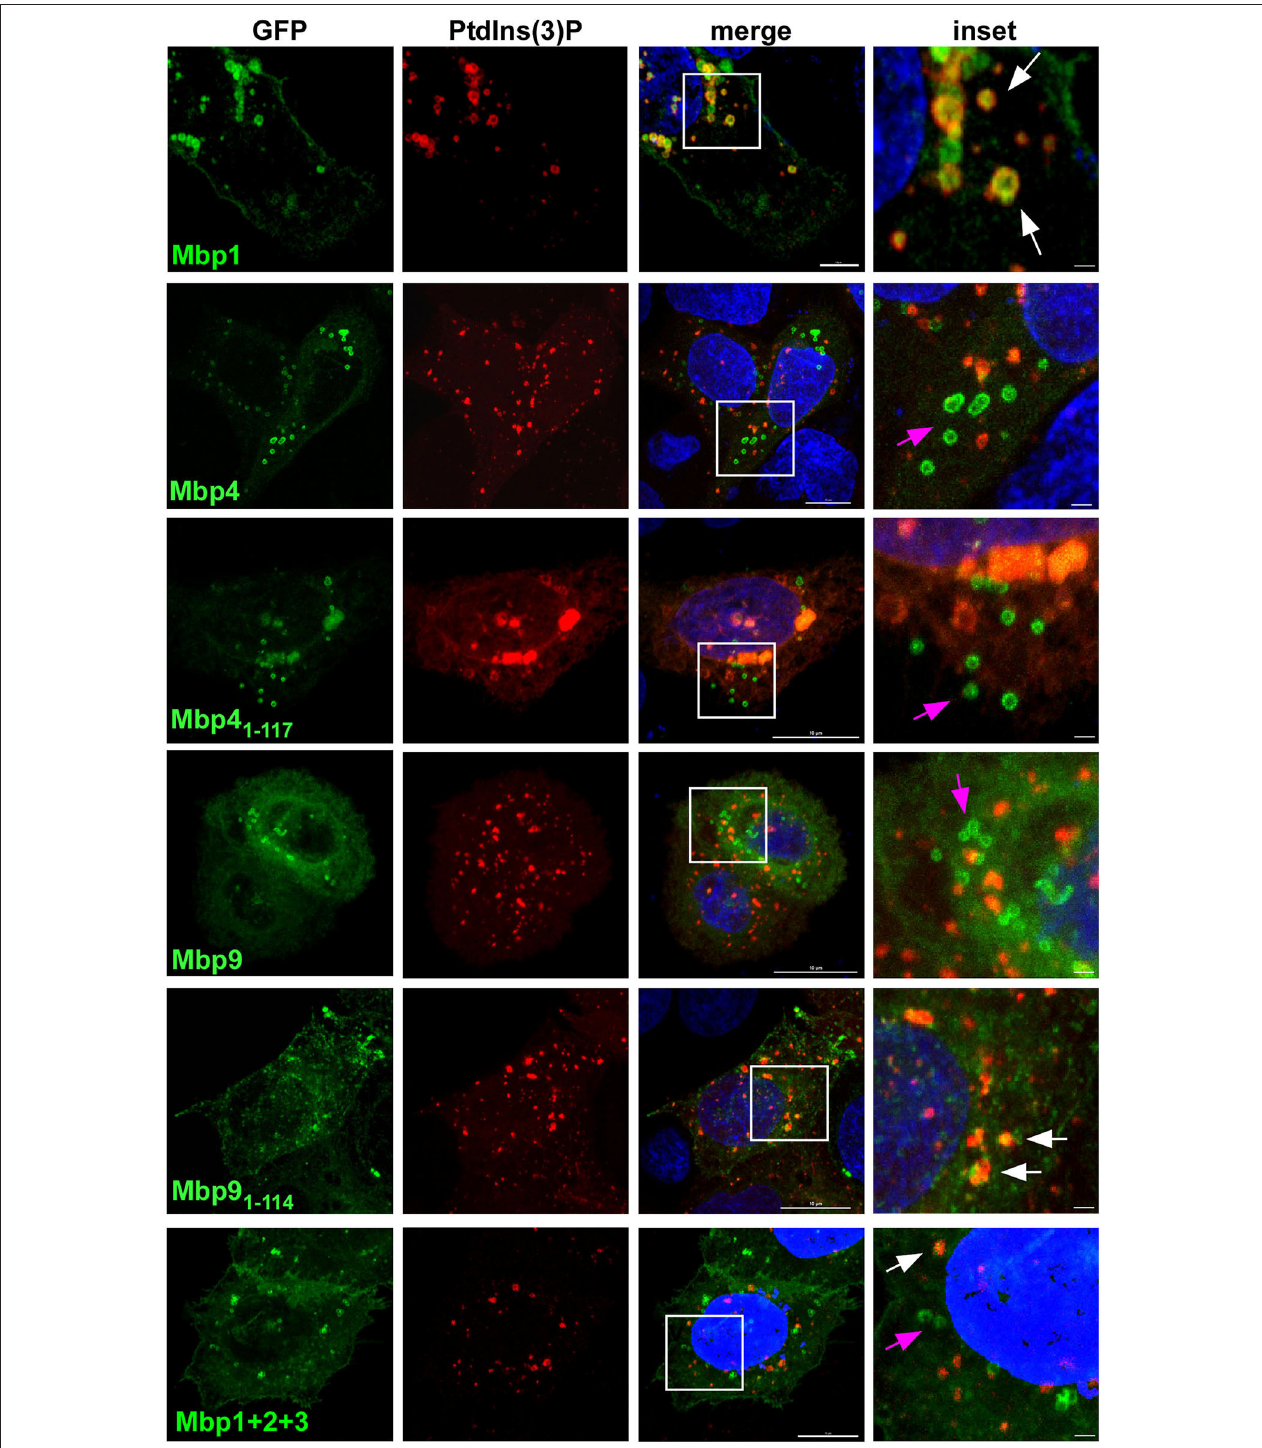
FIGURE 3 | The DUF575-dependent localization to specific membranes is influenced by the presence or absence of the DUF562 domain. Confocal images of cells co-expressing either full length, truncated (only DUF575) or chimera (fusion of three) cluster proteins fused with GFP and 2xFYVE-mCherry, a biosensor for detection of early endosomal membranes positive for PdtIns(3)P. Cells were fixed after 18h of transfection with 3 % PFA. DNA was visualized with Dapi. White box is enlarged in insets. White arrows indicate colocalization of cluster proteins to vesicular structures positive for PdtIns(3), pink arrows indicate cluster proteins on vesicular structures showing no colocalization. Bar: 10 µ m, Insets 1 µ m. The images are representative for 3 different biological replicates ( n = 3).